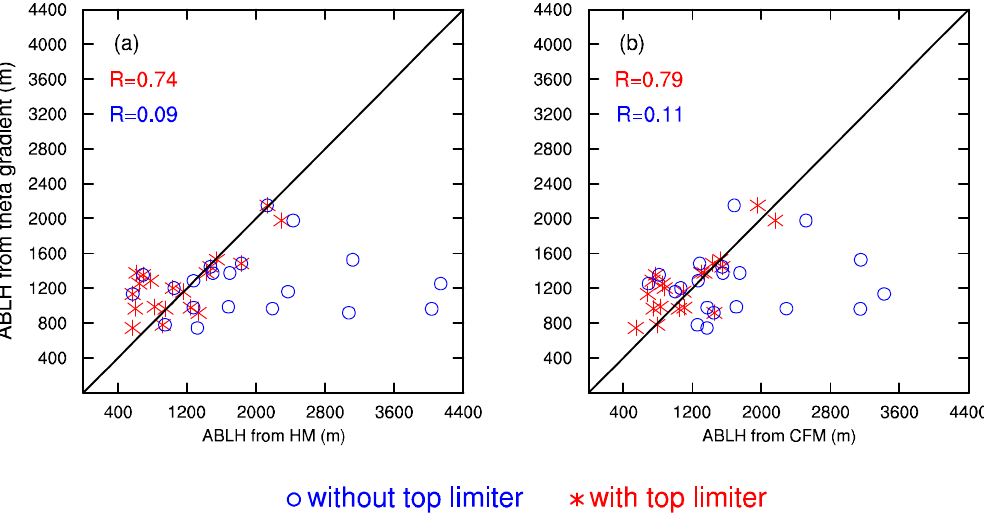
Figure 7. Comparison between radiosonde-determined (vertical coordinate) and lidar measurement (horizontal coordinate) of ABLH by HM ( a ) or CFM ( b ) on 41 cases in cloud-free situations. The correlation coefficients are represented by R. The black solid line is the 1:1 line.